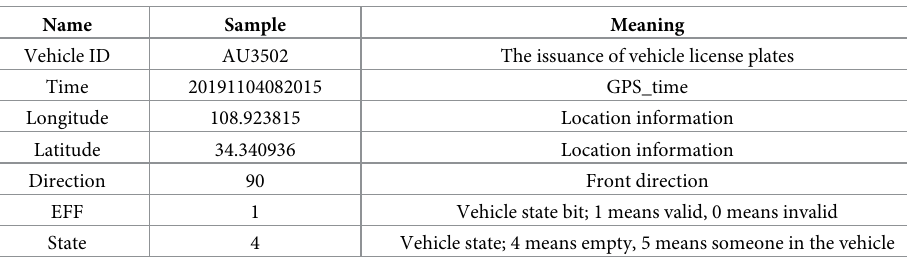
Table 3. Taxi track data